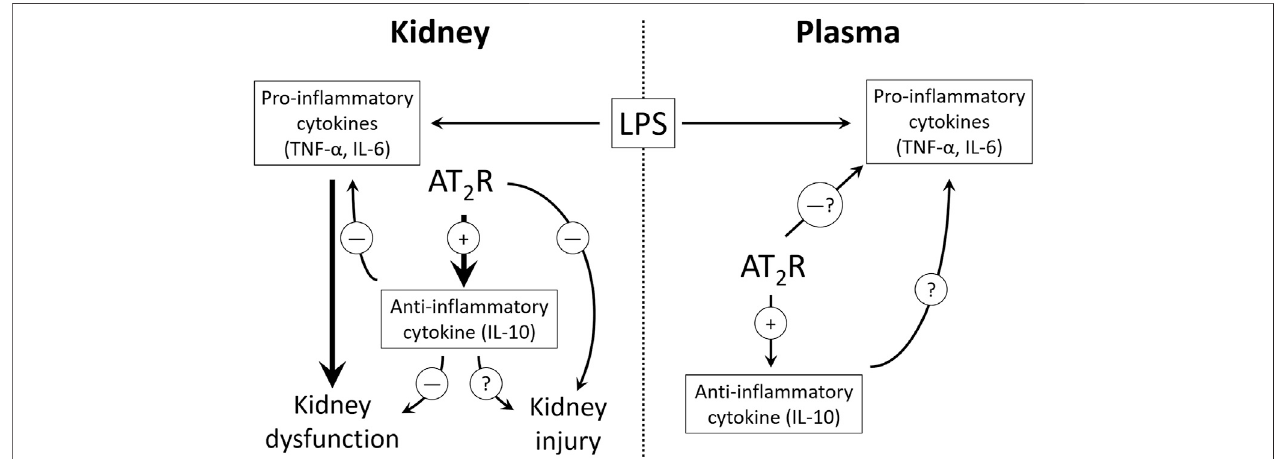
FIGURE 8 | The proposed potential mechanism of AT2R mediated anti-in fl ammation and reno-protection. 10. Table legend.